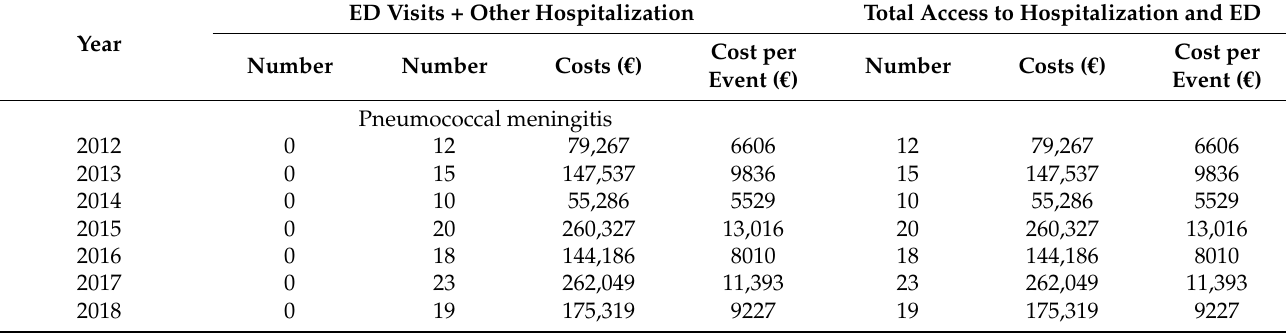
Table 4. Healthcare resource utilization and costs for meningitis for individuals ≥ 15 years of age in the Liguria region